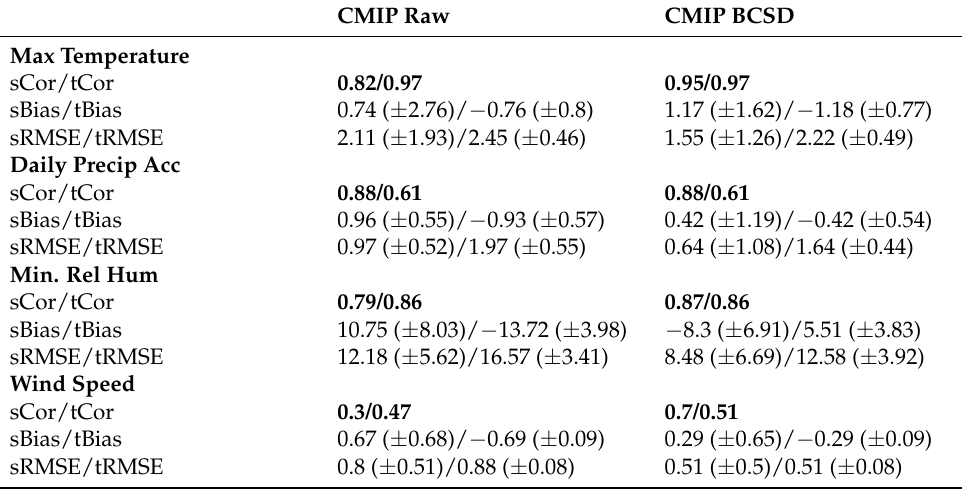
Table 1. Spatial statistics (i.e., sCor) evaluating a 36 year average historical period (1979–2014) of the raw CMIP model ensemble and the bias-corrected and spatially downscaled CMIP model ensemble, against the NARR/TerraClimate validation dataset. Temporal statistics (i.e., tCor) are based on 36 years of monthly averages. Standard deviation is shown in parentheses. Spatial correlations are significant at p < 0.001.